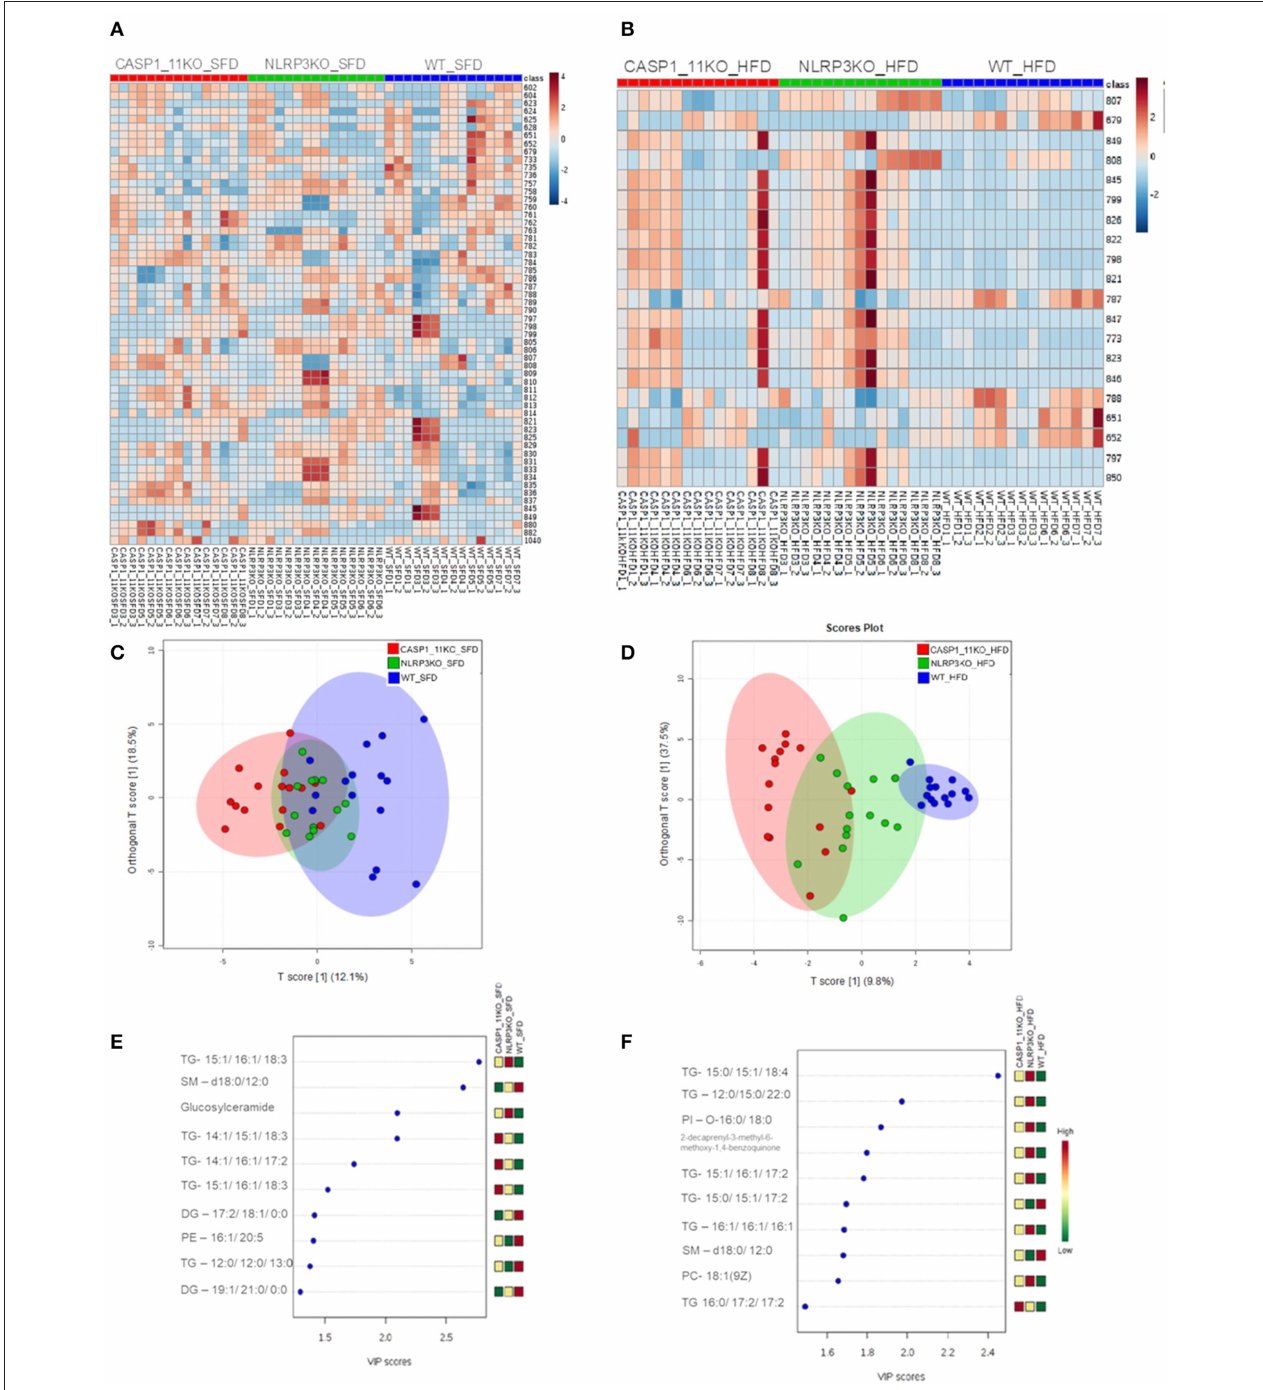
FIGURE 3 | MS/MS analysis of lipid composition in the liver. Heat map, with a color-code thermometer indicating the relative concentrations of metabolites on each group: WT, caspase-1/11 − / − , and Nlpr3 − / − mice fed SFD (17% fat) or HFD (45% fat) for 90 days. Maps show the lipidomic profiles of SFD (A) and HFD (B) groups. Orthogonal partial least squares–discriminant analysis (OPLS-DA) score plots model was constructed using MALDI lipid profiles. Each of the five animals in each group gave rise to three samples. Plots show the lipidomic profiles animals fed with SFD (C) or HFD (D) . Variable importance in projection (VIP) plot identified by partial least squares–discriminant analysis (PLS-DA) displaying the top 10 most important features in mice fed with SFD (E) or HFD (F) .